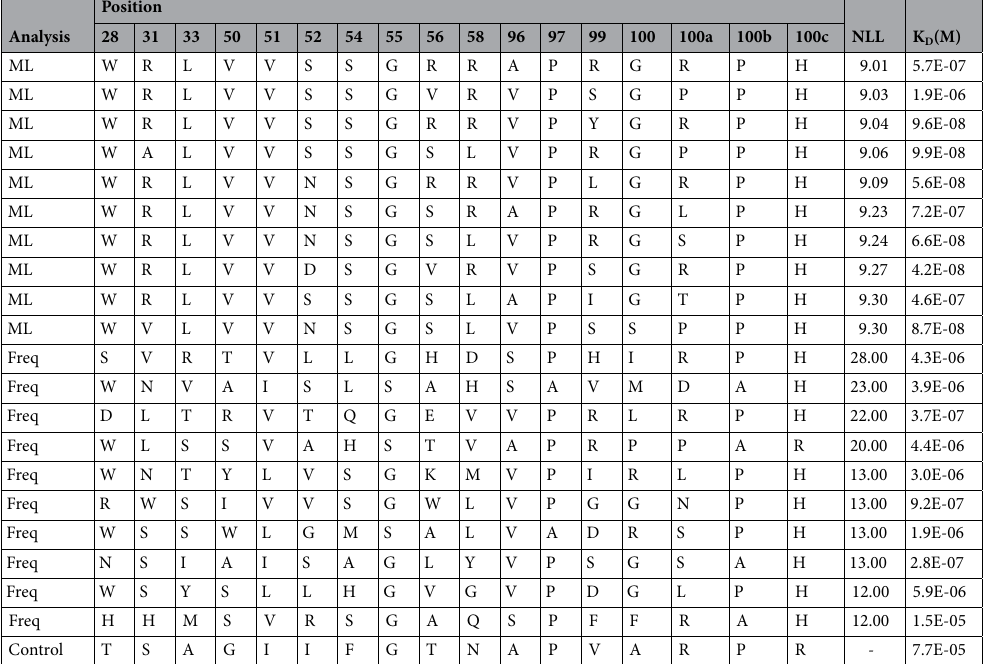
Table 3. Evaluated sequences of anti-kynurenine antibodies. The sequences are categorized into sequences derived from machine learning (ML), sequences derived from NGS total reads (Freq), and the parental sequence (Control). Residues in diversified positions are shown. Likelihood was calculated by the constructed machine learning model. Dissociation constant (K D ) against kynurenine was measured by